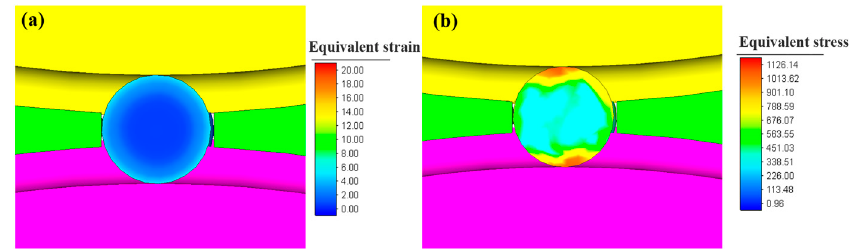
Figure 8. The strain and stress contour along the transverse section of the steel ball: ( a ) equivalent strain and ( b ) equivalent stress.